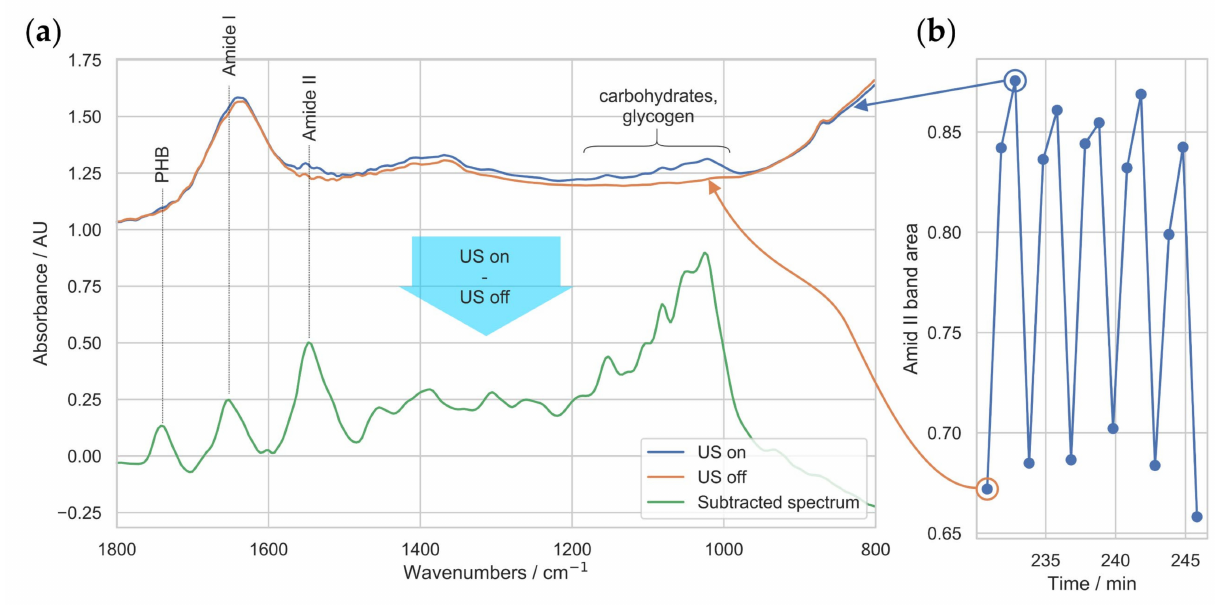
Figure 2. Typical process FTIR spectra. ( a ) Two selected spectra with activated (blue) and deactivated US capture (orange) are depicted on top. Subtraction yielded pure spectra of Synechocystis sp. 6714, shown at bottom (green). ( b ) Integrated signal from the Amide II band, showing modulation occurring when US trap was in pushing mode vs. retracting mode.